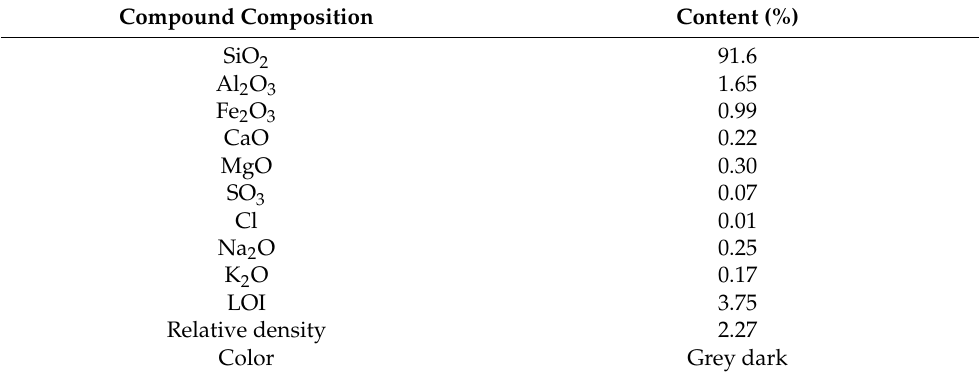
Table 1. Chemical composition and physical properties of SF.